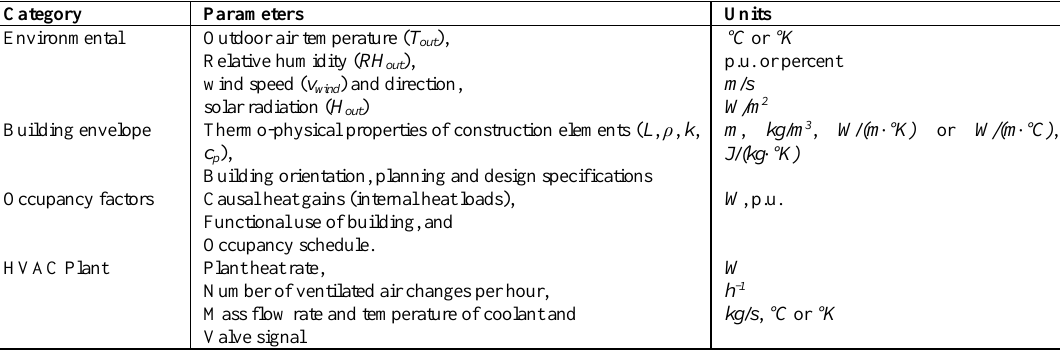
Table 1. Significant parameters used to develop white-box